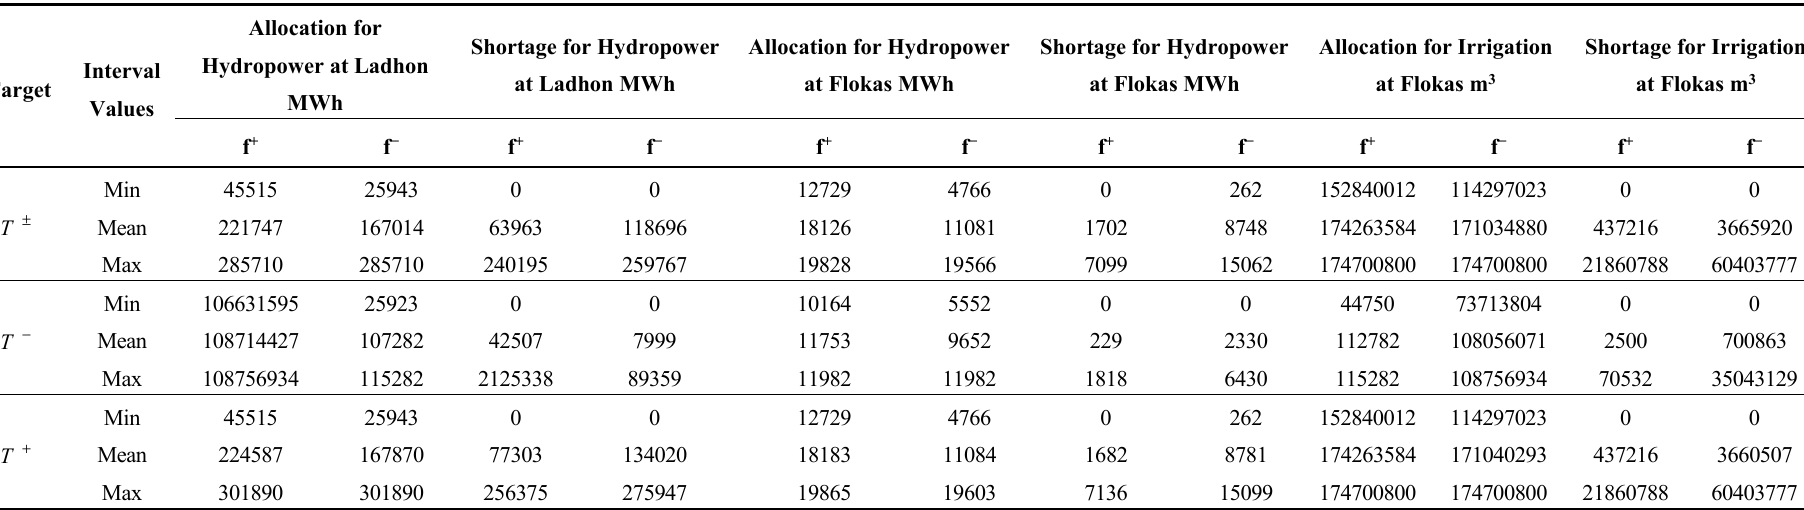
Table 19. Annual water allocation and shortage for irrigation and annual hydropower production and shortage at the HPS at Ladhon and at Flokas (MWh) for optimized targets equal to ± T , − T , + T